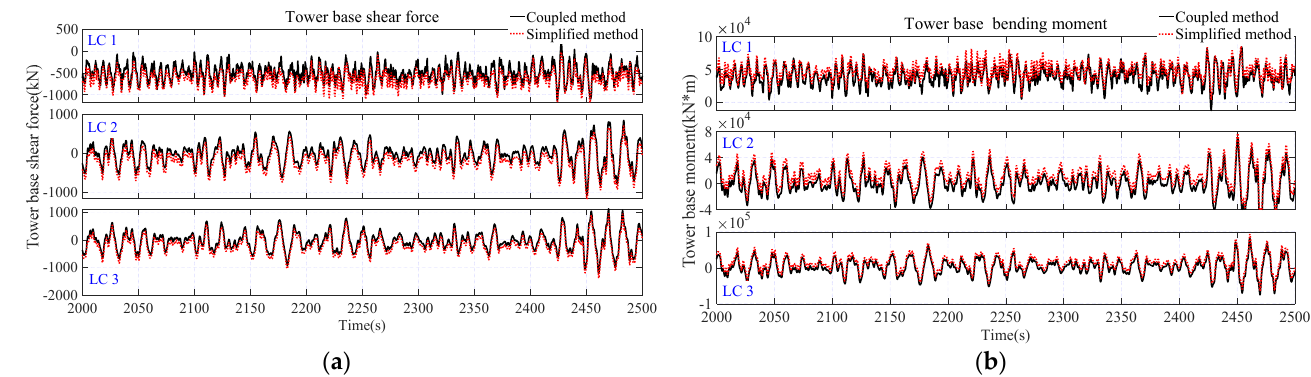
Figures 11 and 12 present a time-domain comparison of the tower base loads and